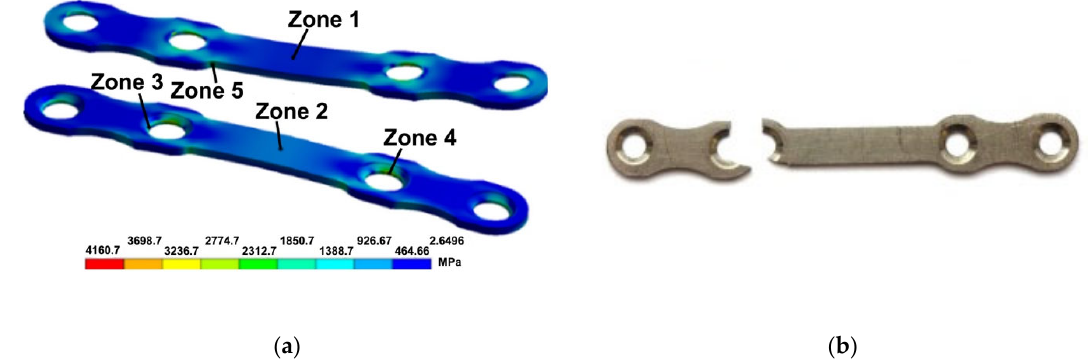
Figure 6. Localized equivalent stresses emerging in different zones of the plates from Ti during tension ( a ) and the characteristic view of the UFG Ti plates after tensile tests ( b ). Zones 1 and 2 are located in the central region of the top and bottom parts of the plates; zones 3 and 4 are located at hole edges; zone 5 is located at the fillets of the plates.